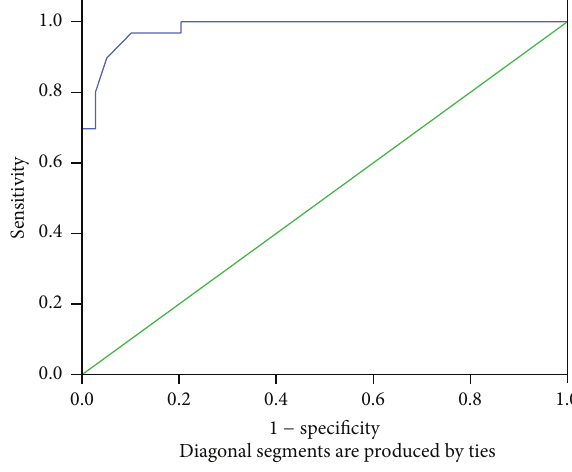
Figure 4: Positive correlation of AHI with MP-H.